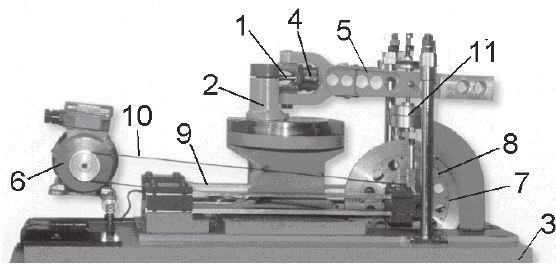
Figure 3: Fatigue test stand MZGS-100 where: 1 – specimen, 2 – rotational head with a holder, 3- bed, 4 - holder, 5 - lever, 6 - motor, 7 – rotating disk, 8 - unbalanced mass, 9 – flat springs, 10 – driving belt, 11 – hydraulic